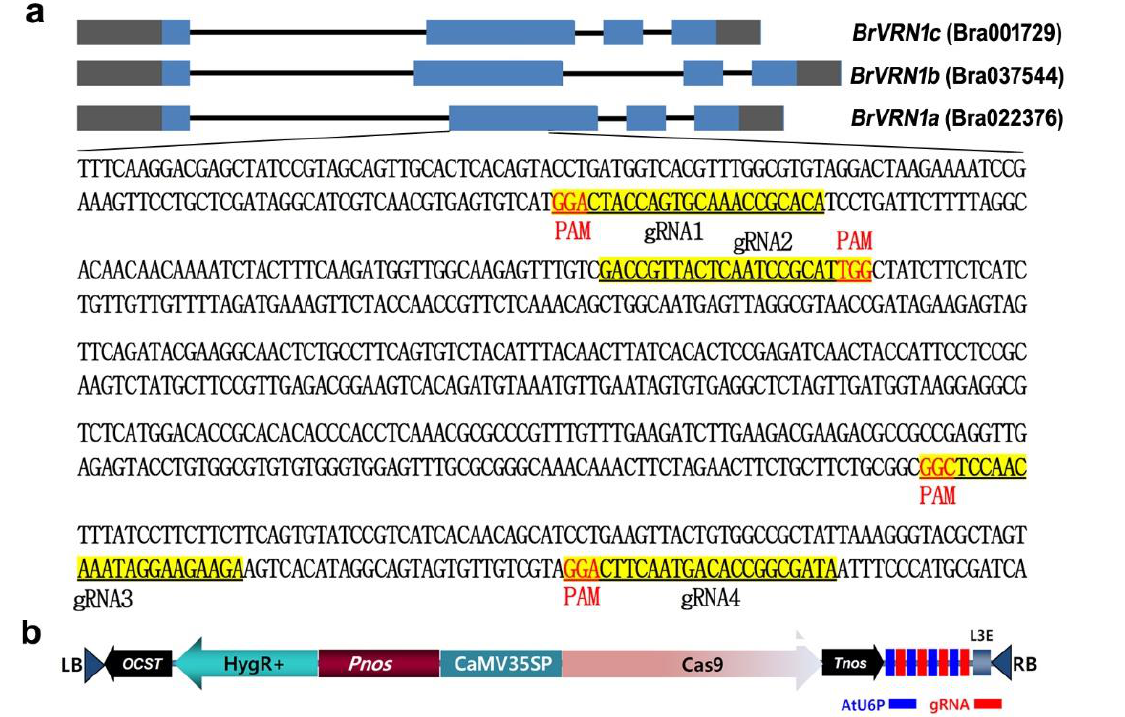
Figure 1. Multiplex gene editing construction of BrVRN1 family gene. ( a ) Gene structure of BrVRN1a with target sites of CRISPR/Cas9 designed in the second exon. Blue stripe, exon; black line, intron; grey stripe, UTR (untranslated regions). The underlined nucleotides indicate the target sites (named gRNA1 to gRNA4). Nucleotides in red represent PAM sequences. PAM, protospacer adjacent motif. ( b ) Structure of CRISPR/Cas9 platform with BrVRN1a four sgRNAs vector based on pAGM4723. AtU6P, Arabidopsis U6 promoter; Pnos , nopaline synthase promoter; Tnos , nopaline synthase terminator; LB, left border; RB, right border; HygR+, hygromycin-resistance gene; OCST , octopine synthase terminator; L3E, end linker 3; CaMV35P, 35S promoter.